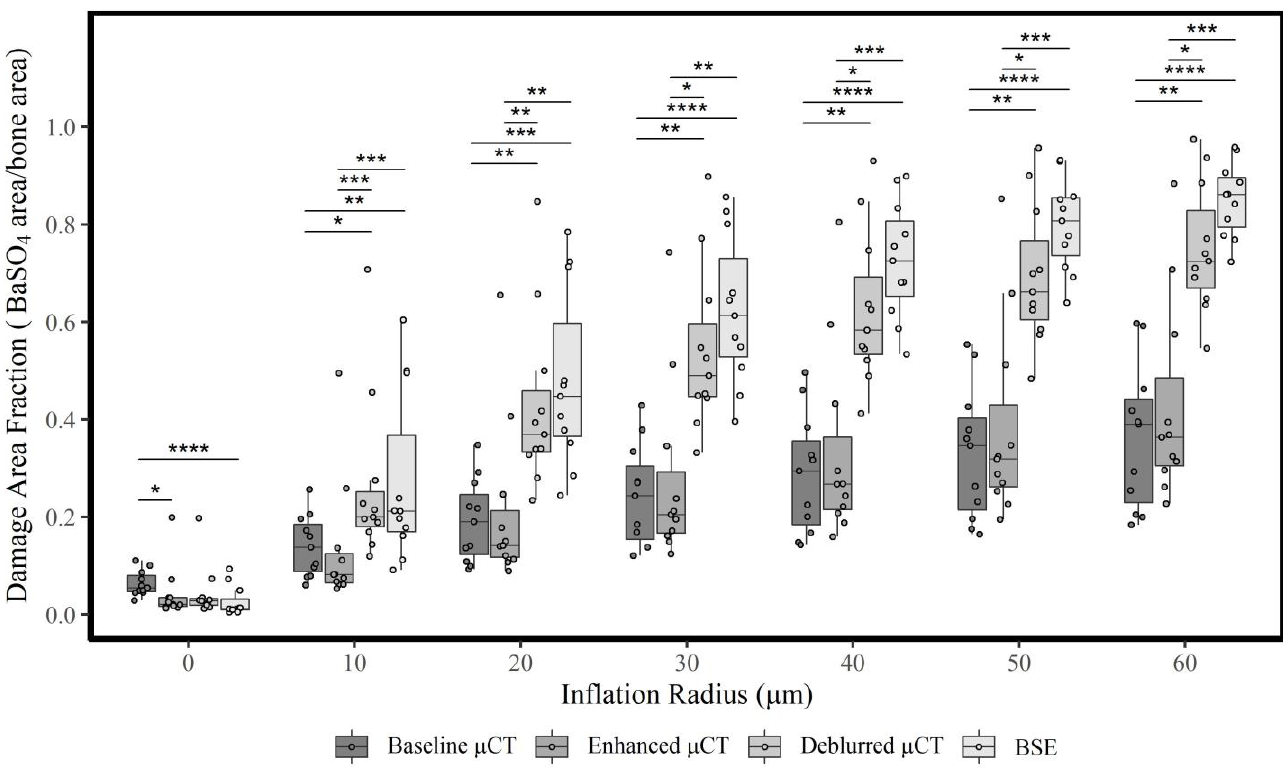
Figure 4. Damage area fractions (BaSO 4 area/bone area) of BaSO 4 label fields in µCT and BSE images before (radius = 0 µm) and after convolution inflating the label fields at six radii. The data represented are from eleven sagittal BSE slides from rat L1 vertebrae (healthy = 5, osteolytic = 3, mixed = 3). * p < 0.05, ** p < 0.01, *** p < 0.001, **** p < 0.0001, Nemenyi pair-wise comparison.